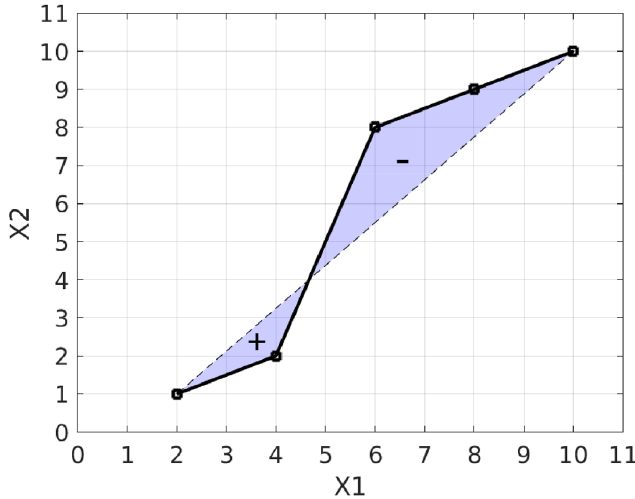
Fig 4. Geometric interpretation of an area term in the log signature. The term has an area equal to the upper shaded region subtracted from the lower shaded region which in this example evaluates to -5. The log signature has a single term for the area between the path and its chord whereas the signature uses two area terms. The log signature of degree 2 in this example is {8, 9, − 5}.